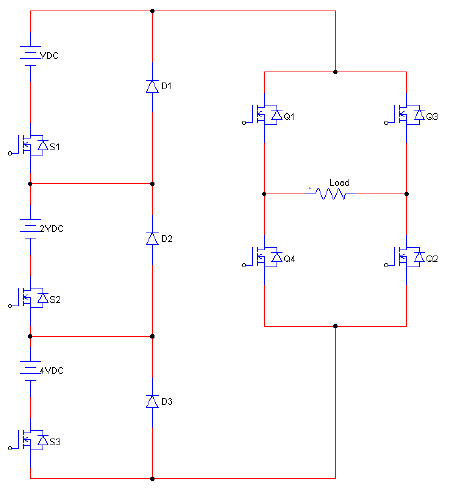
Figure 14. Circuit diagram for three-phase MLI. Figure 13. and 14. Circuit diagram for three-phase MLI.